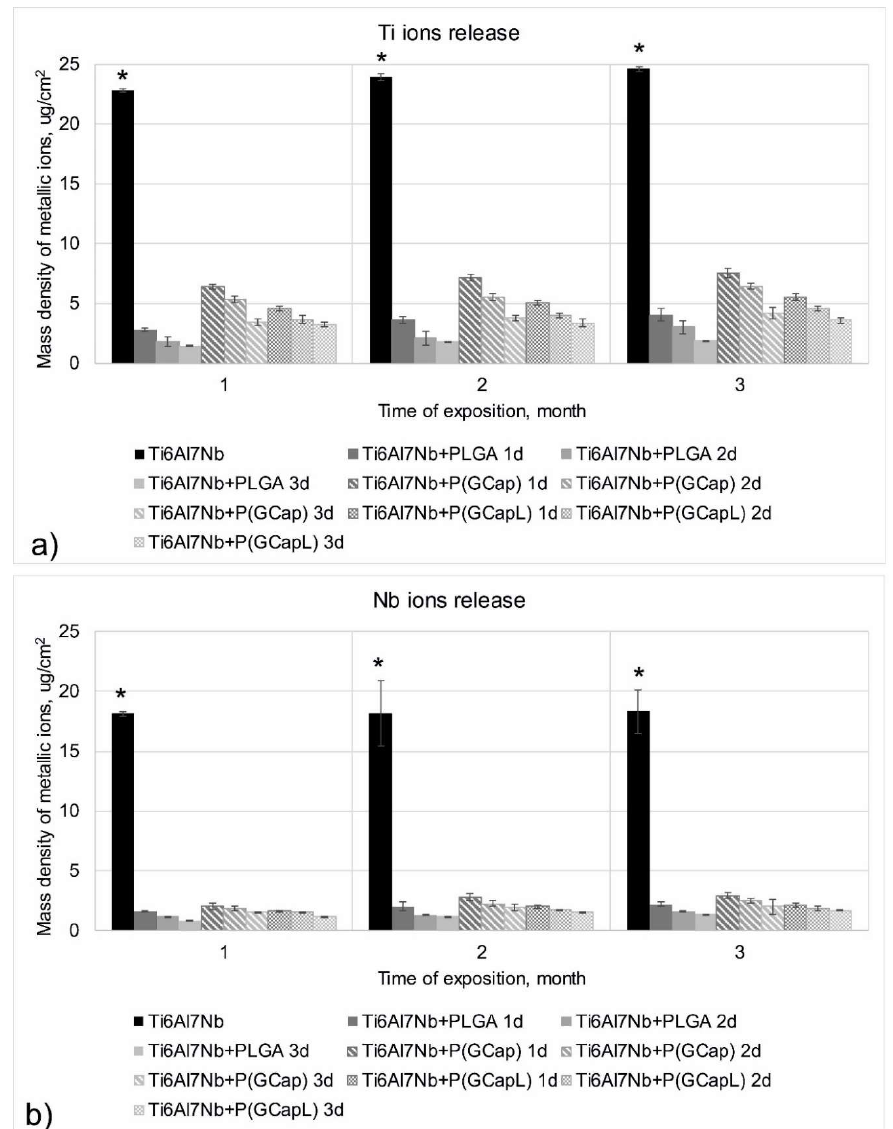
Figure 4. The mean values of the mass of ions density releasing from the surface of the samples coated with a biodegradable polymer coating in the function of the type of the polymer, the parameters of its obtaining, and exposure time: a ) Ti ions release and b ) Nb ions release ( * p < 0.05 versus the control